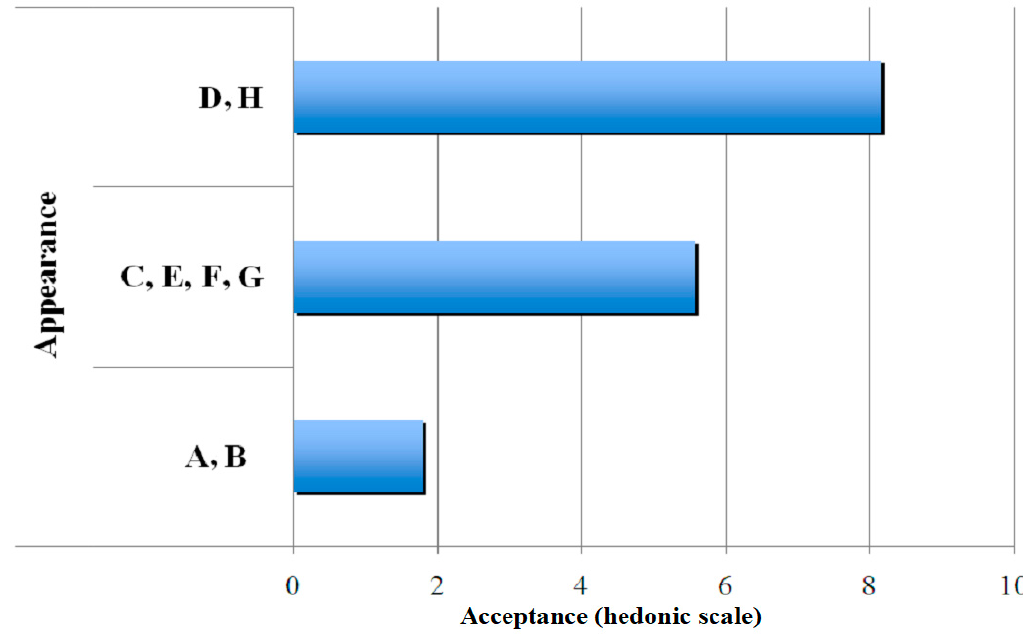
Figure 4. Results of clustering of gelatin-gal base samples for the attribute, appearance.